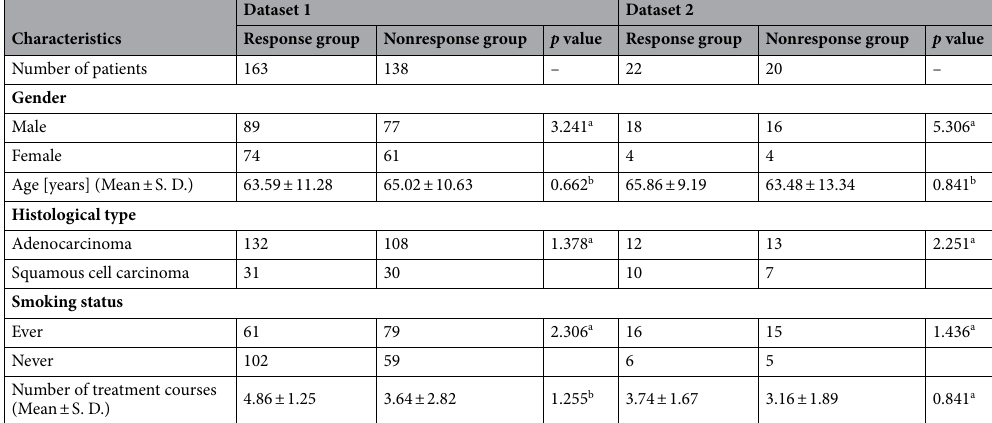
Table 1. Clinical characteristics of NSCLC patients. a p value for the Chi-square test; b p-value for the two- sample t